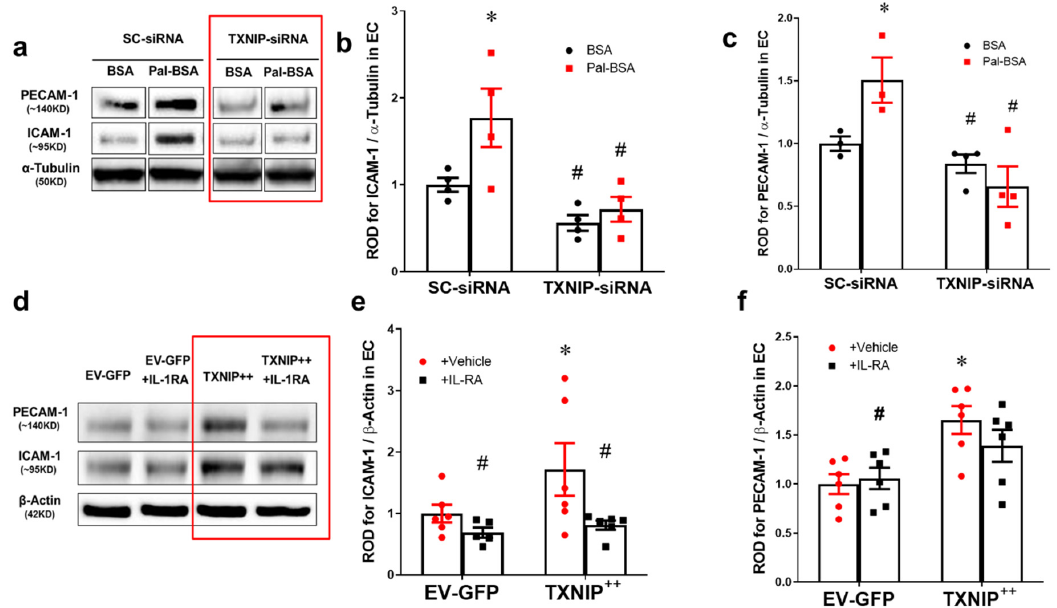
Figure 6. Silencing of TXNIP abolishes, while its overexpression induces, REC adhesion molecule upregulation in an IL-1 β -dependent fashion. ( a ) Representative WB blots (boxes denote separate lanes from the same gel) and statistical analyses of ( b ) ICAM-1 and ( c ) PECAM-1 protein expression showed higher levels in cells incubated with PAL-BSA compared with BSA controls in the scrambled-siRNA group. Silencing TXNIP expression using siRNA abolished such responses. Two-way ANOVA showed significant interaction between Pal-BSA and silencing TXNIP expression across PECAM-1 levels ( n = 3–4, each measurement was performed in duplicate using two di ff erent cell preparations; * p < 0.05 vs. SCsiRNA + BSA, # vs. SCsiRNA + Pal-BSA). ( d ) Representative blots and WB analysis of ( e ) ICAM-1 and ( f ) PECAM-1 protein expression showed higher levels in TXNIP overexpression (TXNIP ++ + vehicle) group compared with EV-GFP + vehicle control group, respectively. Treatment of TXNIP-overexpressing REC with 100 ng / mL of IL-1RA (TXNIP ++ + IL-1RA) suppressed the e ff ect of TXNIP overexpression on expression of REC adhesion molecules ( n = 5–6, each measurement was performed in triplicate using two di ff erent cell preparations; * p < 0.05 vs. EV-GFP + vehicle, # vs. TXNIP + + + vehicle).